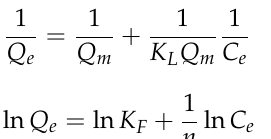
Figure S2: FTIR spectra of Pseudomonas stutzeri , SDB and PSDB (4000 to 500 cm − 1 ), Figure S3: Ni 2+ tolerance of Pseudomonas stutzeri at 50 mg L − 1 , Figure S4: Effect of initial pH on Ni 2+ removal by Pseudomonas stutzeri